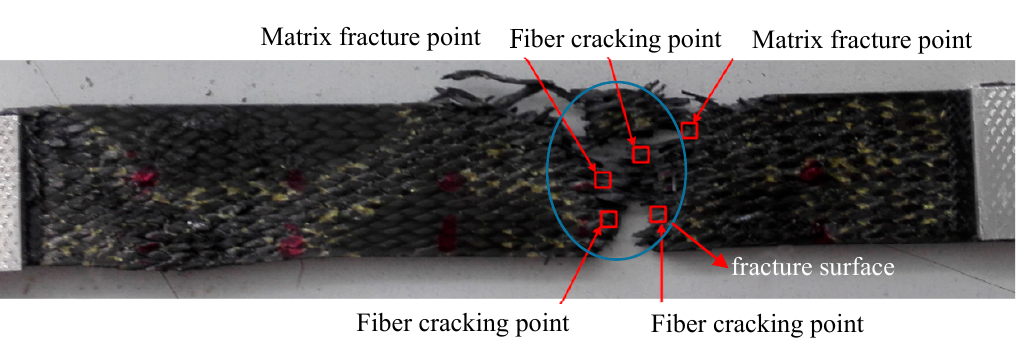
Figure 7. Location of Damage Source in Tensile Test.